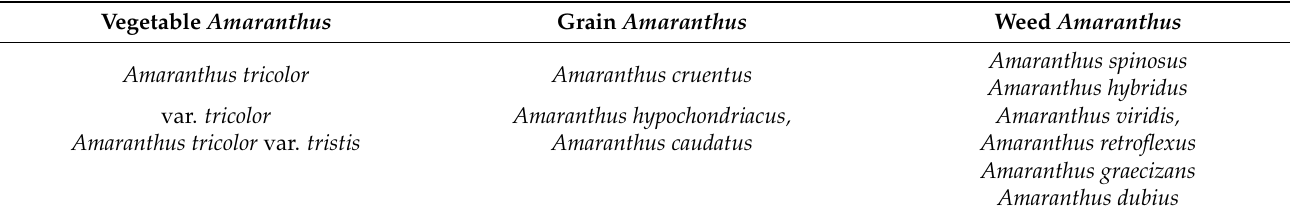
Figure 2. ( A – C ). Variant of Amaranthus spinosus . Table 1. Classification and description of Amaranthus